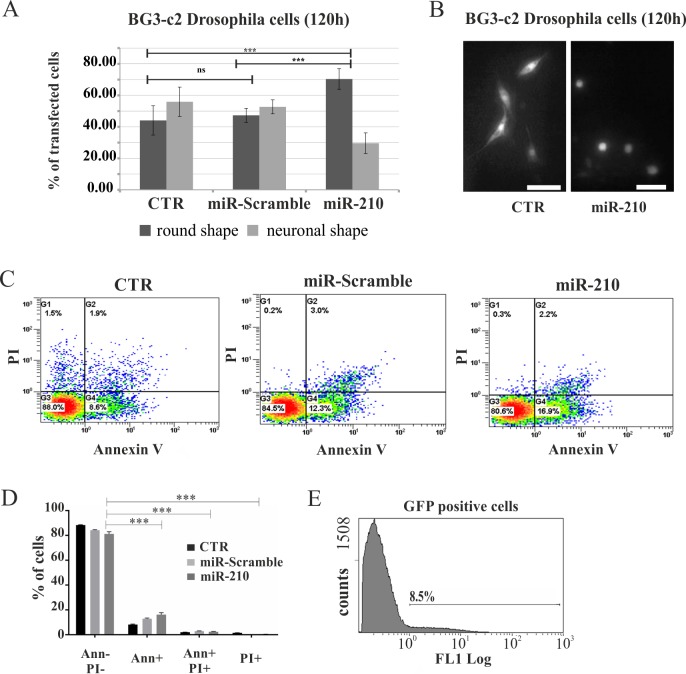
miR-210 over-expression in Drosophila BG3-c2 neuronal cells.(A) BG3-c2 Drosophila neuronal cells were co-transfected with pUAST-miR-210, p-Act-Gal4 and p-Act5c-stable-neo-GFP (miR-210) or pUAST-miR-Scramble, p-Act-Gal4 and p-Act5c-stable-neo-GFP (miR-Scramble). In addition, co-transfaction with p-Act-Gal4 and p-Act5c-stable-neo-GFP was used as a control (CTR). (A) Histograms show the percentage of transfected cells (GFP-positive), measured after 120 hours from transfection, with round or neuronal shapes. t test: ***p<0.005, ns: not significant. (B) GFP expression in BG3-c2 Drosophila cells transfected with miR-210 (right panel) and control (left panel) after 120 hours (see above for details). It should be noted that most of the neurons treated with miR-210 exhibited a round shape. Scale bar 36 μm. (C) Representative plots of BG3-c2 GFP positive cells (CTR, miR-Scramble and miR-210) 120 hours post-transfection and double-stained with Annexin V and propidium iodide (PI). (D) The histogram shows the higher percentage of GFP positive live cells (Annexin V-/PI-), with respect to early apoptotic (Annexin V+), or late apoptotic/necrotic cells (Annexin V+/PI+ and PI+, t test *** p<0.001) of all treated samples. (E) BG3-c2 transfection efficiency.